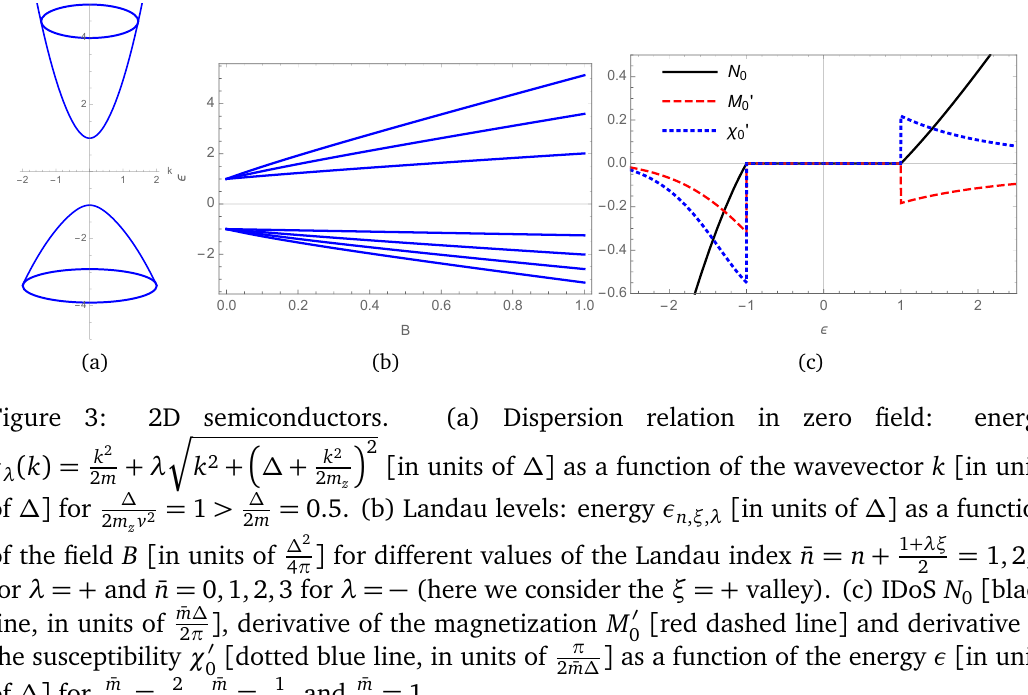
[ in units of ∆ ] as a function n , ξ , λ [ red dashed line ] and derivative of 0 ] as a function of the energy ε [ in units 2¯ m ∆ + λξ and with λ = ± 1 the band 2